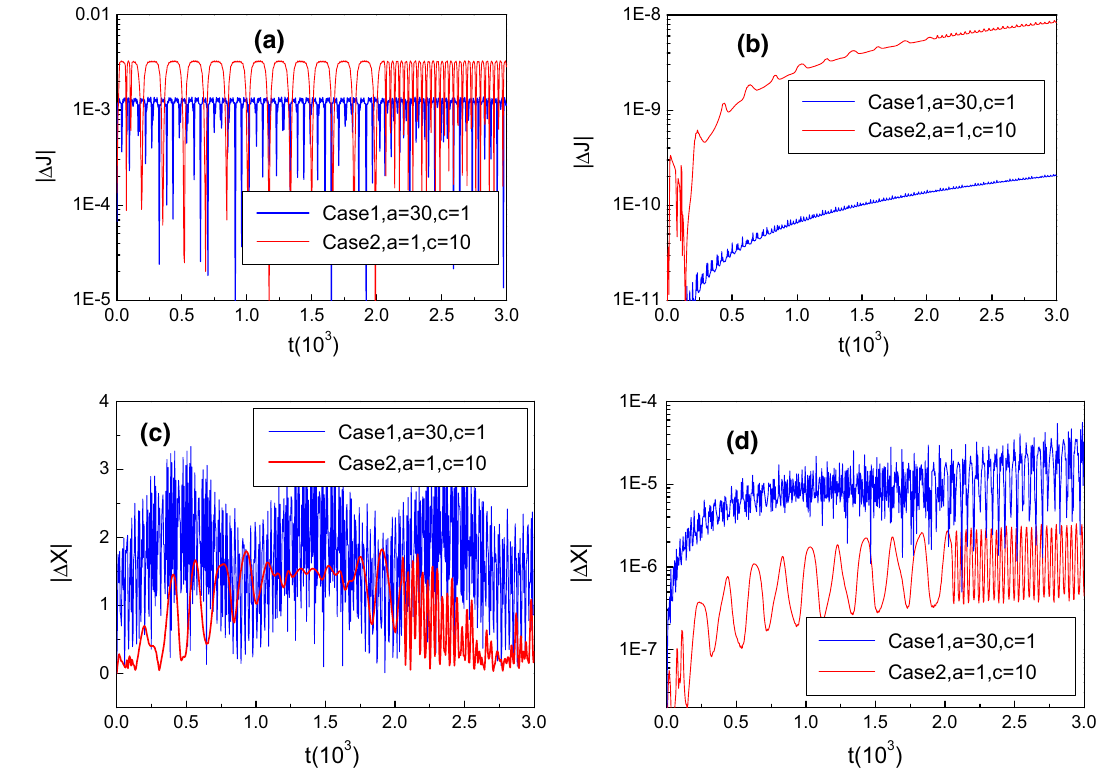
Fig. 3 Errors Δ J of the Jacobian constant and orbital errors Δ X for Orbit 1 solved by RK4 with the stepsize h = 0 . 01: a , c the 1PN truncated system; b , d the exact system